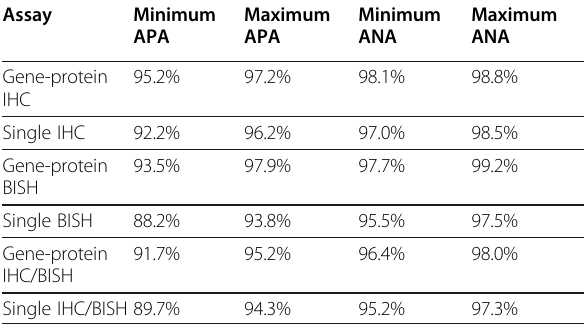
Table 8 Summary of inter-reader agreement analyses